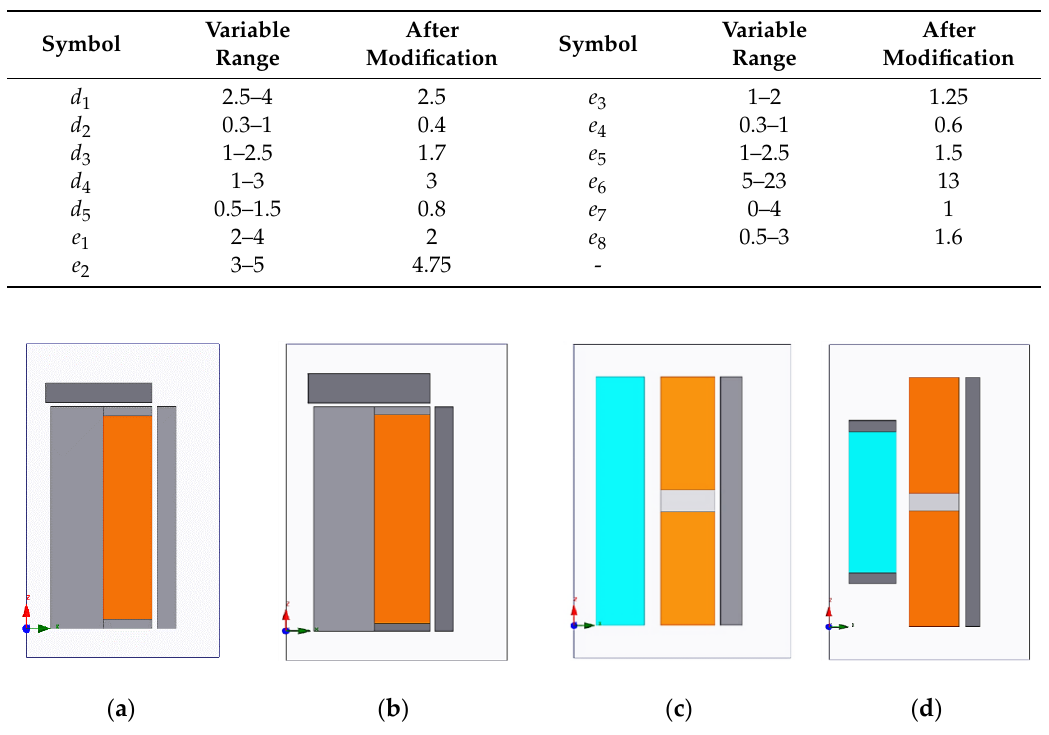
Figure 9. Models before and after modification. ( a,b ) SA model before and after modification; and ( c,d ) MCA and MMA models before and after